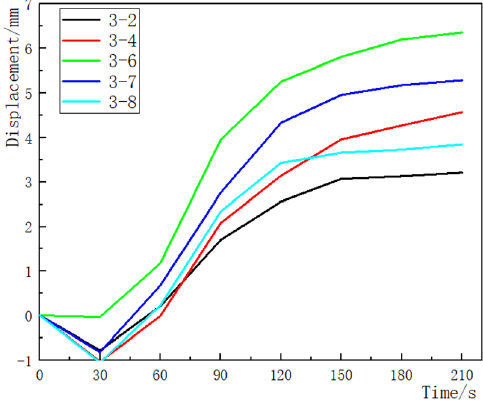
Fig. 12 Displacement variation curves for monitoring